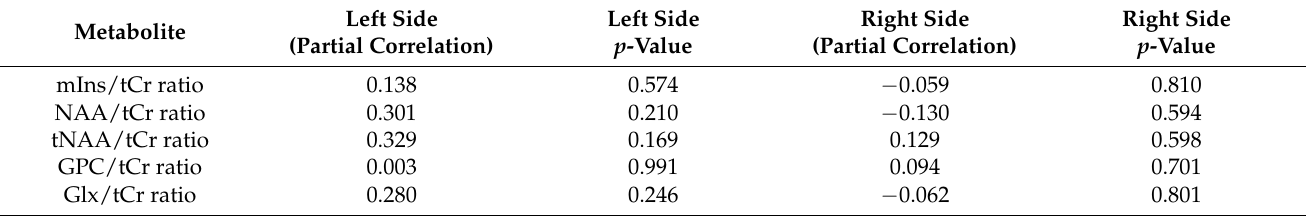
Table 5. Partial Correlation between the GMV of Parietal Operculum 2 and Metabolite a